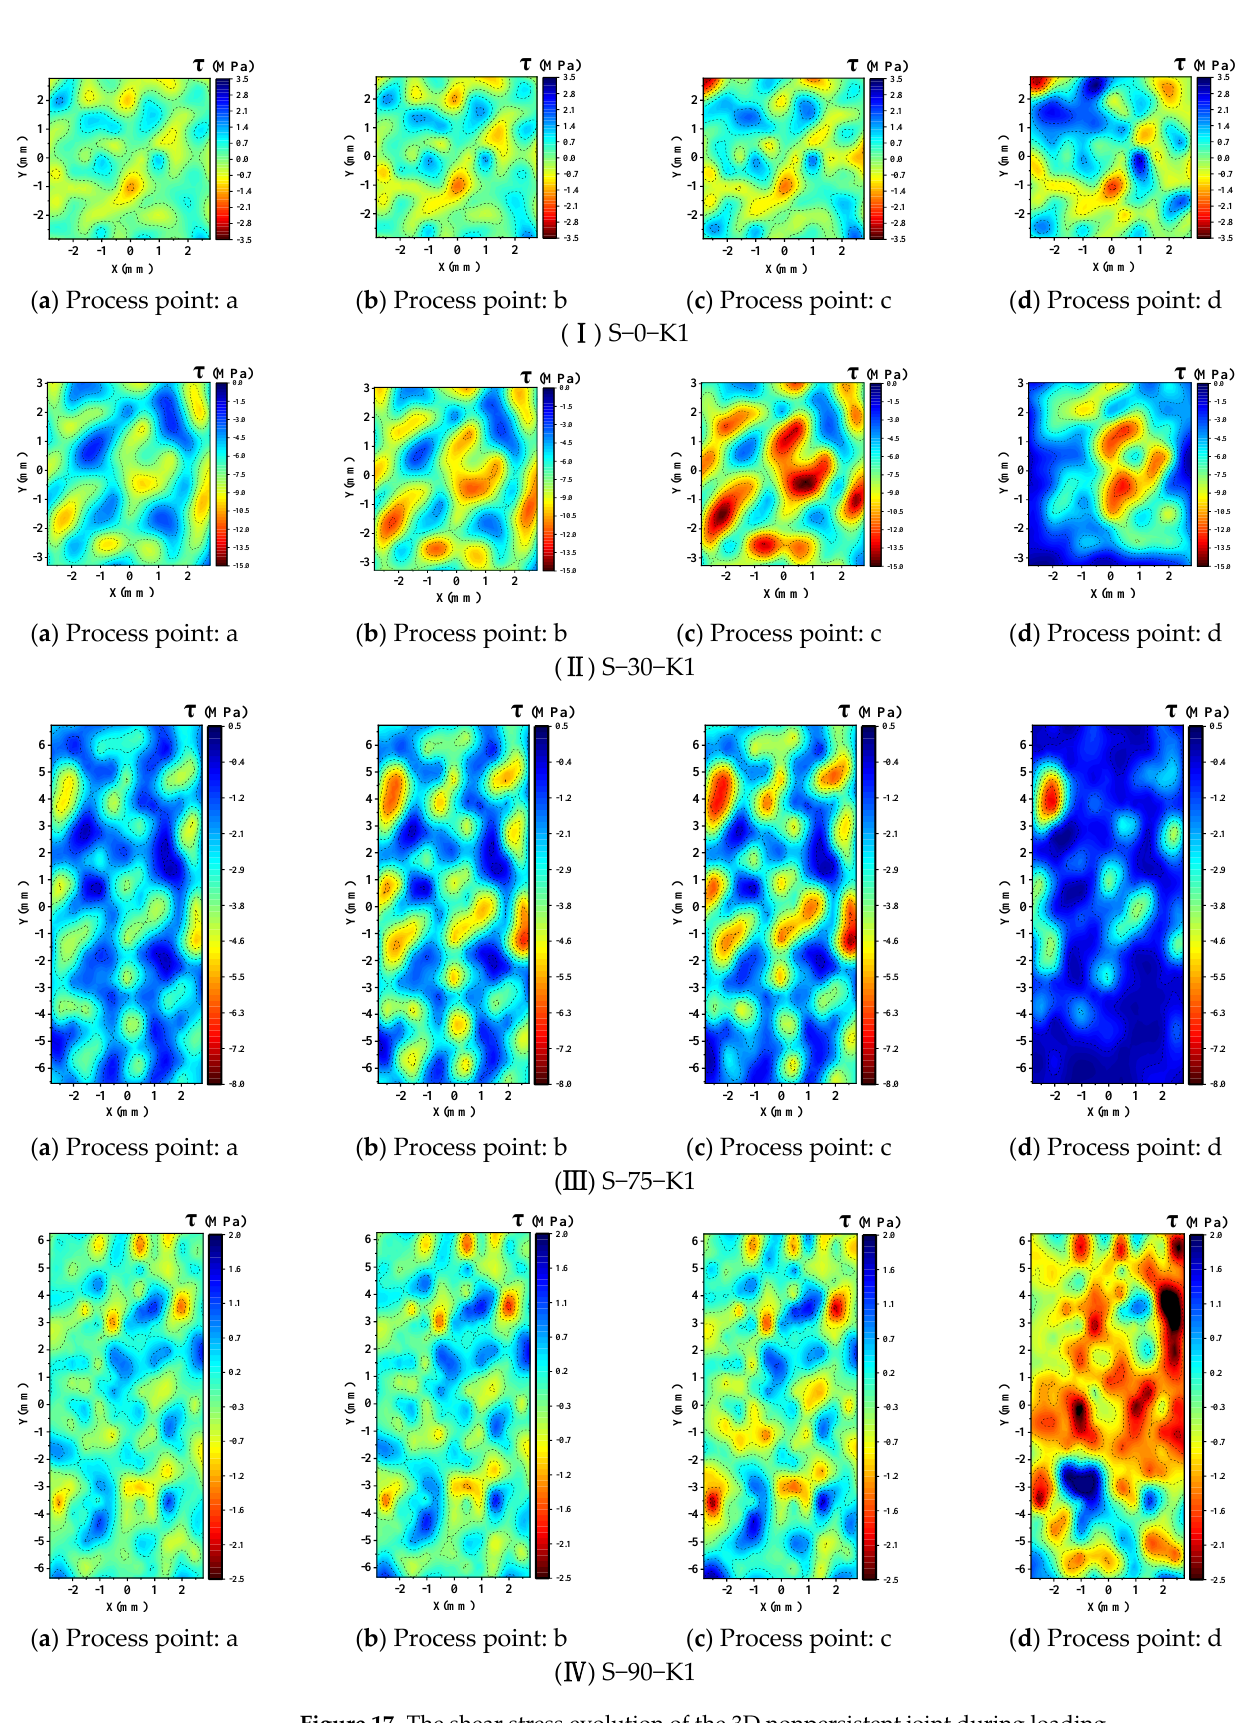
Figure 17. The shear stress evolution of the 3D nonpersistent joint during